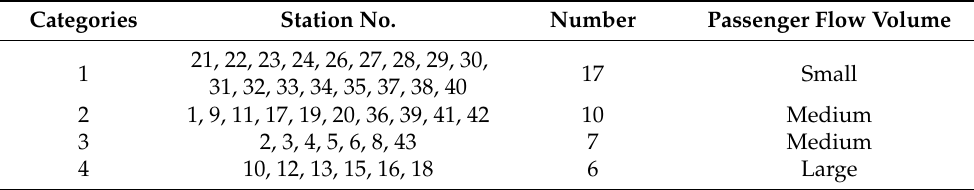
Figure 5. Visualization of inflow in the four categories of stations in 15 min time interval in the Xiamen BRT. ( a ) Inflow visualization in the first category; ( b ) inflow visualization in the second category; ( c ) inflow visualization in the third category; ( d ) inflow visualization in the fourth category. Table 6. Station classification results in the Xiamen BRT in 15 min time interval. Table 5. Names of stations in the Xiamen BRT.